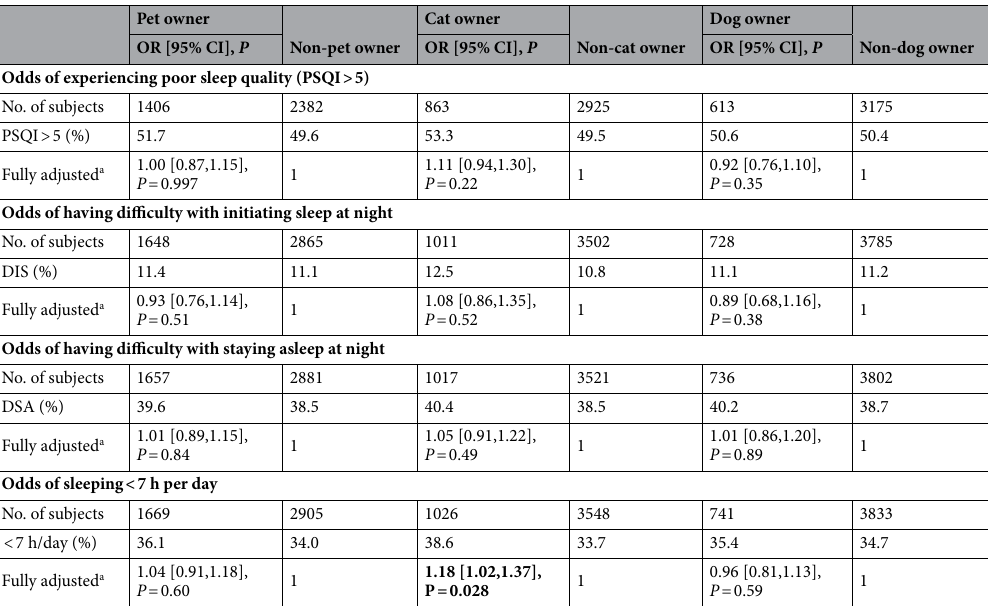
Table 2. Association between pet ownership and sleep in the SCAPIS cohort (Uppsala). CI, confidence interval; DIS, difficulty initiating sleep; DSA, difficulty staying asleep; No., number; OR, odds ratio; PSQI, Pittsburgh Sleep Quality Index. a Logistic regression was adjusted for the following variables: sex, education, age, BMI, social interaction, regular physical activity, alcohol frequency, socio-economic stability, night shift work, diabetes, sleep apnea, constant stress, current smoking.